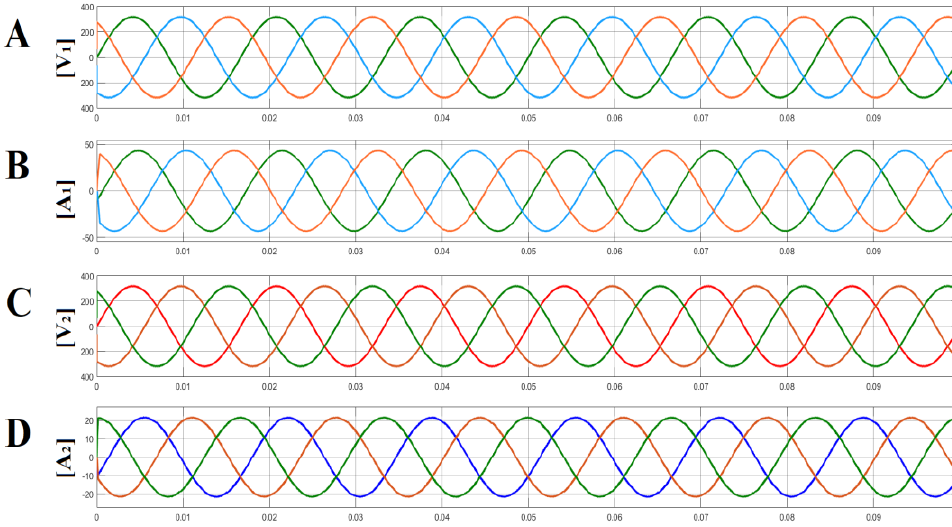
Figure 12. The waveform of output voltages and currents ( A , B ) of DG1 and ( C , D ) of DG2 in GC mode.